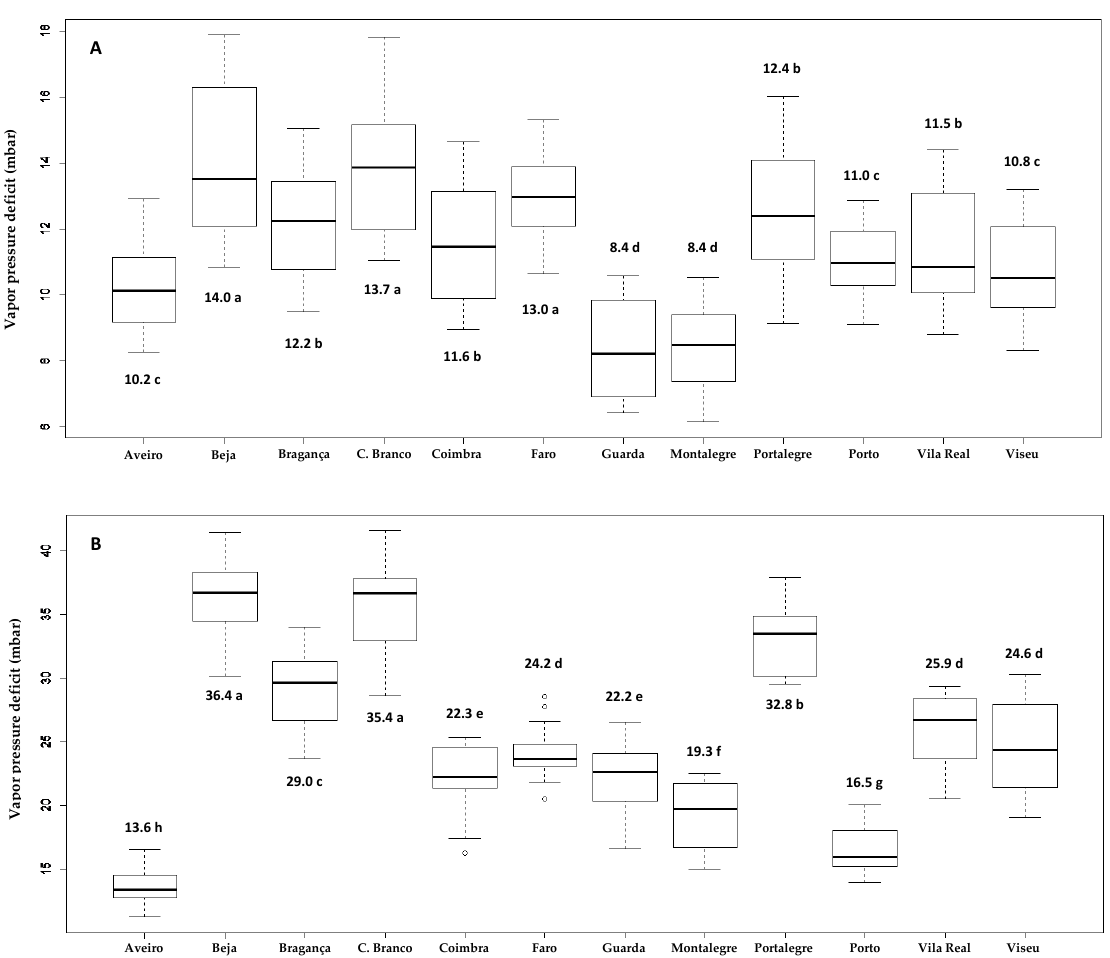
Figure 2. Box-plot graphs of mean water vapor pressure deficits in twelve areas of mainland Portugal in the spring ( A ) (February to May) and summer ( B ) (June to September) from 2004 to 2018 (ANOVA: February to May, F = 17.04, p < 0.001; June to September, F = 91.00, p < 0.001). Highlighted means with the same letters were not di ff erent by Scott–Knott grouping test ( p <